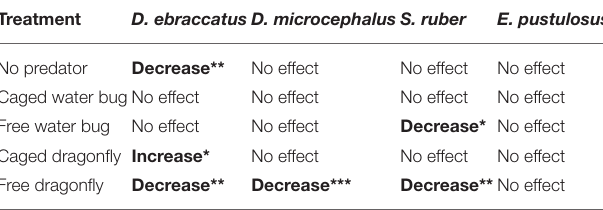
TABLE 3 | Effects of competition on δ 15 N, with respect to predation.